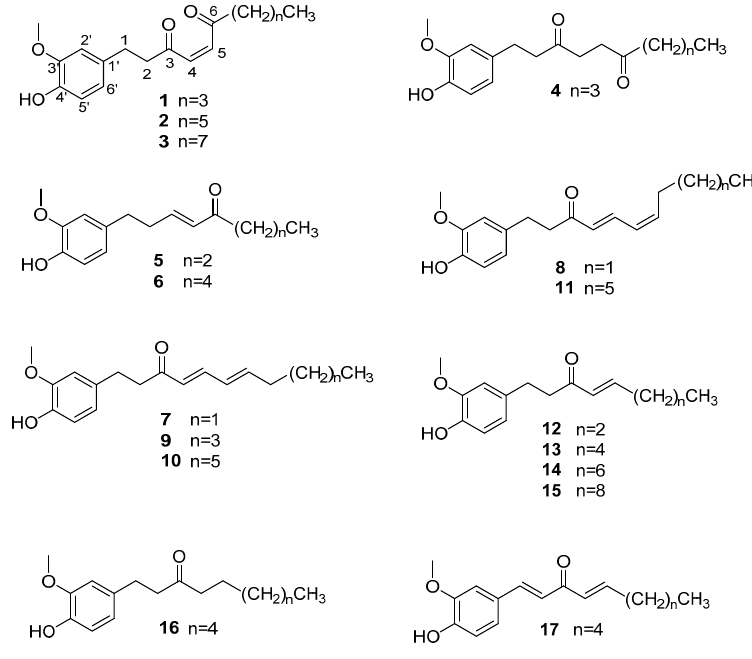
Figure 1. Structures of compounds 1 – 17 .